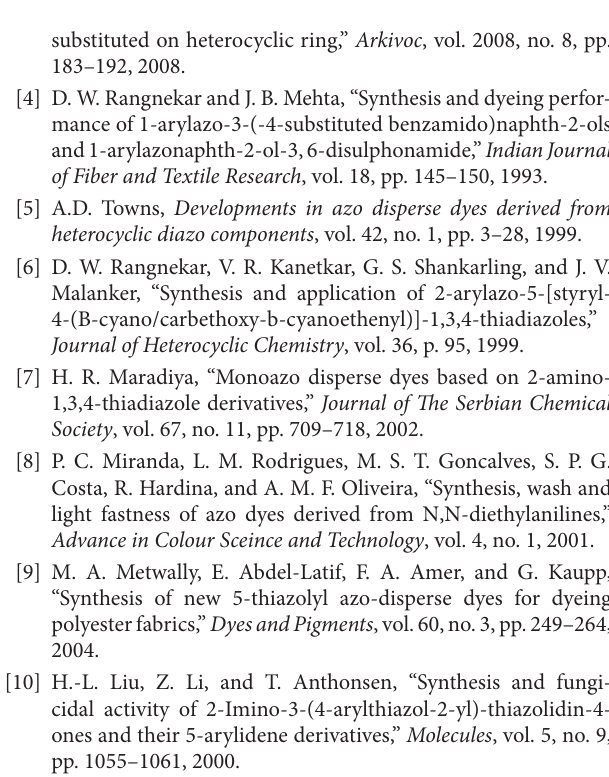
T 4: IR and NMR data of D